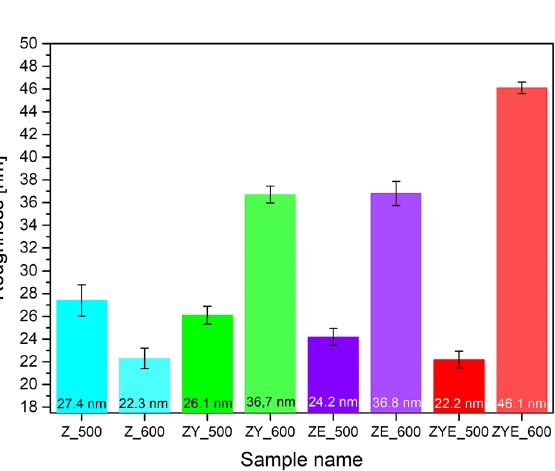
Figure 4. A 3D and 2D AFM images of scanned micro-areas of 10 × 10 µm thin films: ( a ) Z_500, ( b ) Z_600, ( c ) ZY_500, ( d ) ZY_600, ( e ) ZE_500, ( f ) ZE_600, ( g ) ZYE_500 and ( h ) ZYE_600.